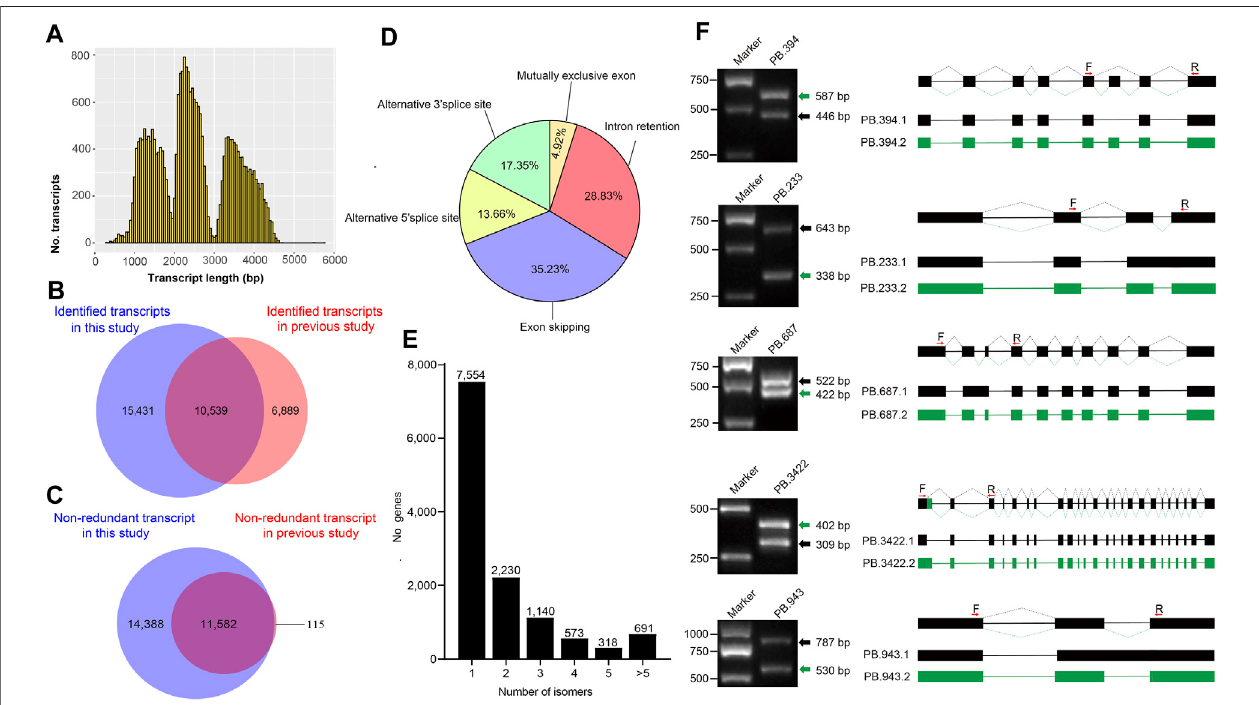
FIGURE 1 | Non-redundant transcripts and alternative splicing events ( A ) The distribution of all non-redundant transcripts length ( B ) The Venn diagram shows the comparative results of the transcript identi fi ed in this study and the previously reported transcript ( C ) The Venn diagram shows the comparative result between the non- redundanttranscriptsidenti fi edinthisstudyandthepreviouslyreportedtranscriptsinsilkwormsilkgland( D )Proportionofeachalternativesplicingtype( E )Distributionof spliceisoformsofgenes( F ) Therandomselectedalternativesplicingeventswereveri fi ed byPolymerase ChainReaction(PCR) and Sangersequencing.Primers (F representforwardprimerandRrepresentreverseprimer)weredesignedbasedon fl ankingregionsofalternativesplicingsites.ThePCRproductwasrunon1%agarose gel and observed in UV light. For each gel, the green and black arrows indicate different splicing isoforms. The structures of the isoforms are showed on the right side of the fi gure. The fi lled boxes represent Exons and lines represent introns. Different isoforms are showed with different color box connected by lines. The red arrows upon the boxes represent the locations sites of the primers.